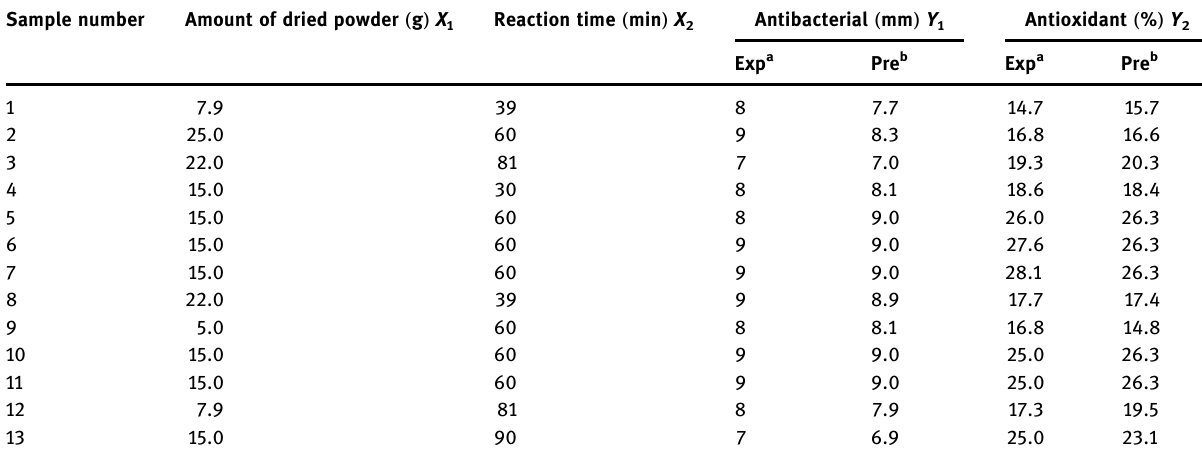
Table 2: Experimental runs based on the central composite design and response variables for ZnO NPs synthesis Sample